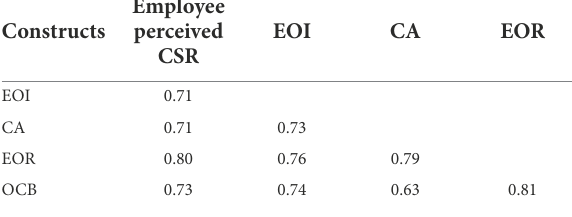
TABLE 3 Standardized direct and indirect effects of employee CSR perceptions on